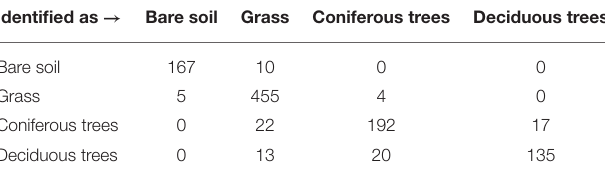
TABLE 3 | The confusion matrix of CNN